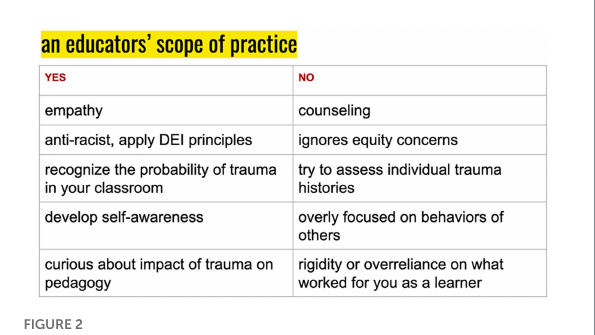
FIGURE 2 An educator’s scope of practice, used with permission from Dr.